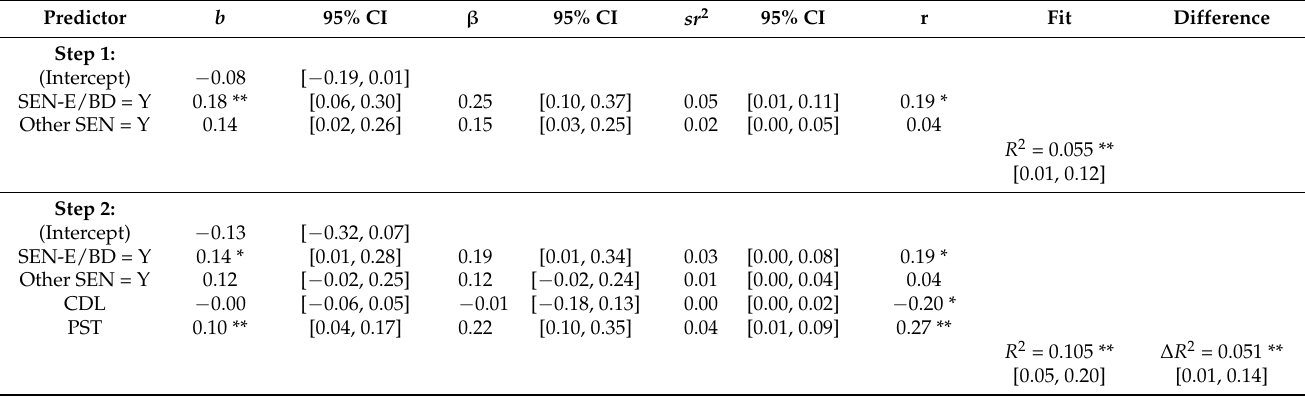
Table 7. Regression results using the lockdown effect on IP as the